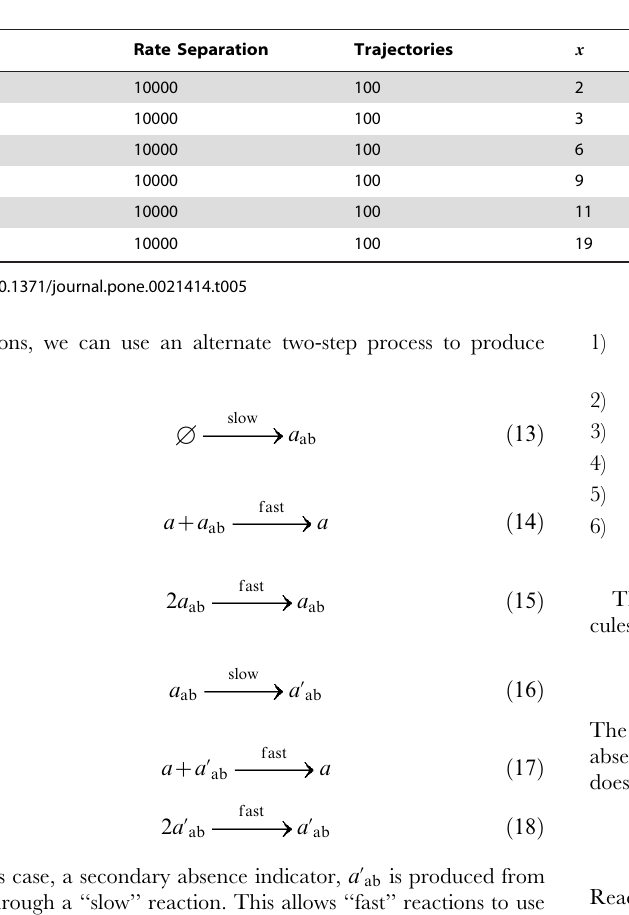
Table 5. Statistical Simulation Results from ‘‘Exponentiation’’ Construct.